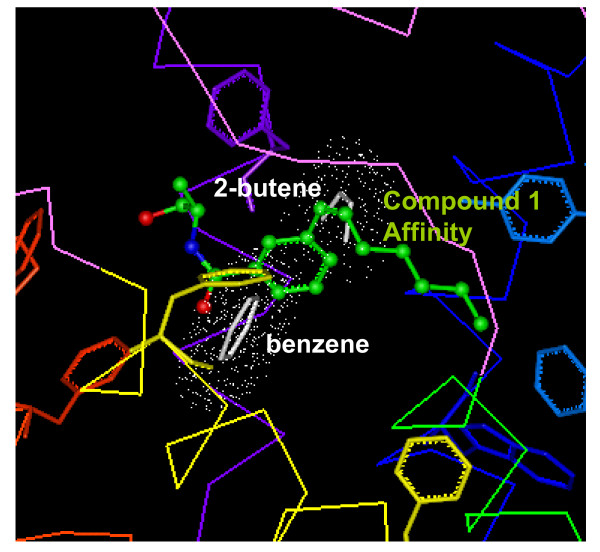
Comparison of the best position of the benzene and cis-2-butene moieties from MCSS with the Affinity/SA model of compound 1. Aromatic residues at or around the ligand binding pocket are represented including F3.25(189) and F7.35(379) identified as potentially important residues for aromatic stacking with compound 1.